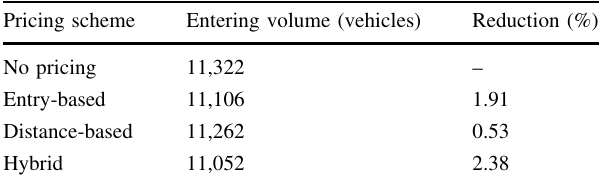
Table 7 Input flow to cordoned area for different toll designs for Sioux Falls Pricing